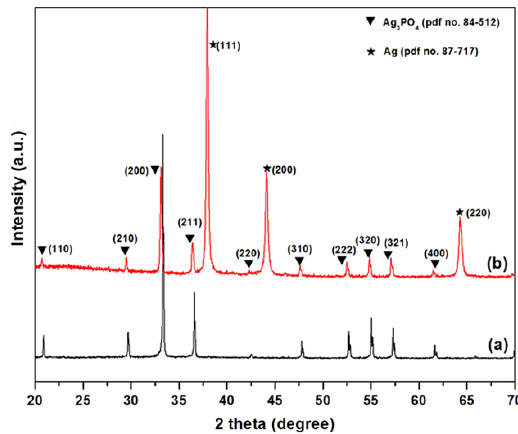
Figure 3. SEM images of (a) Ag